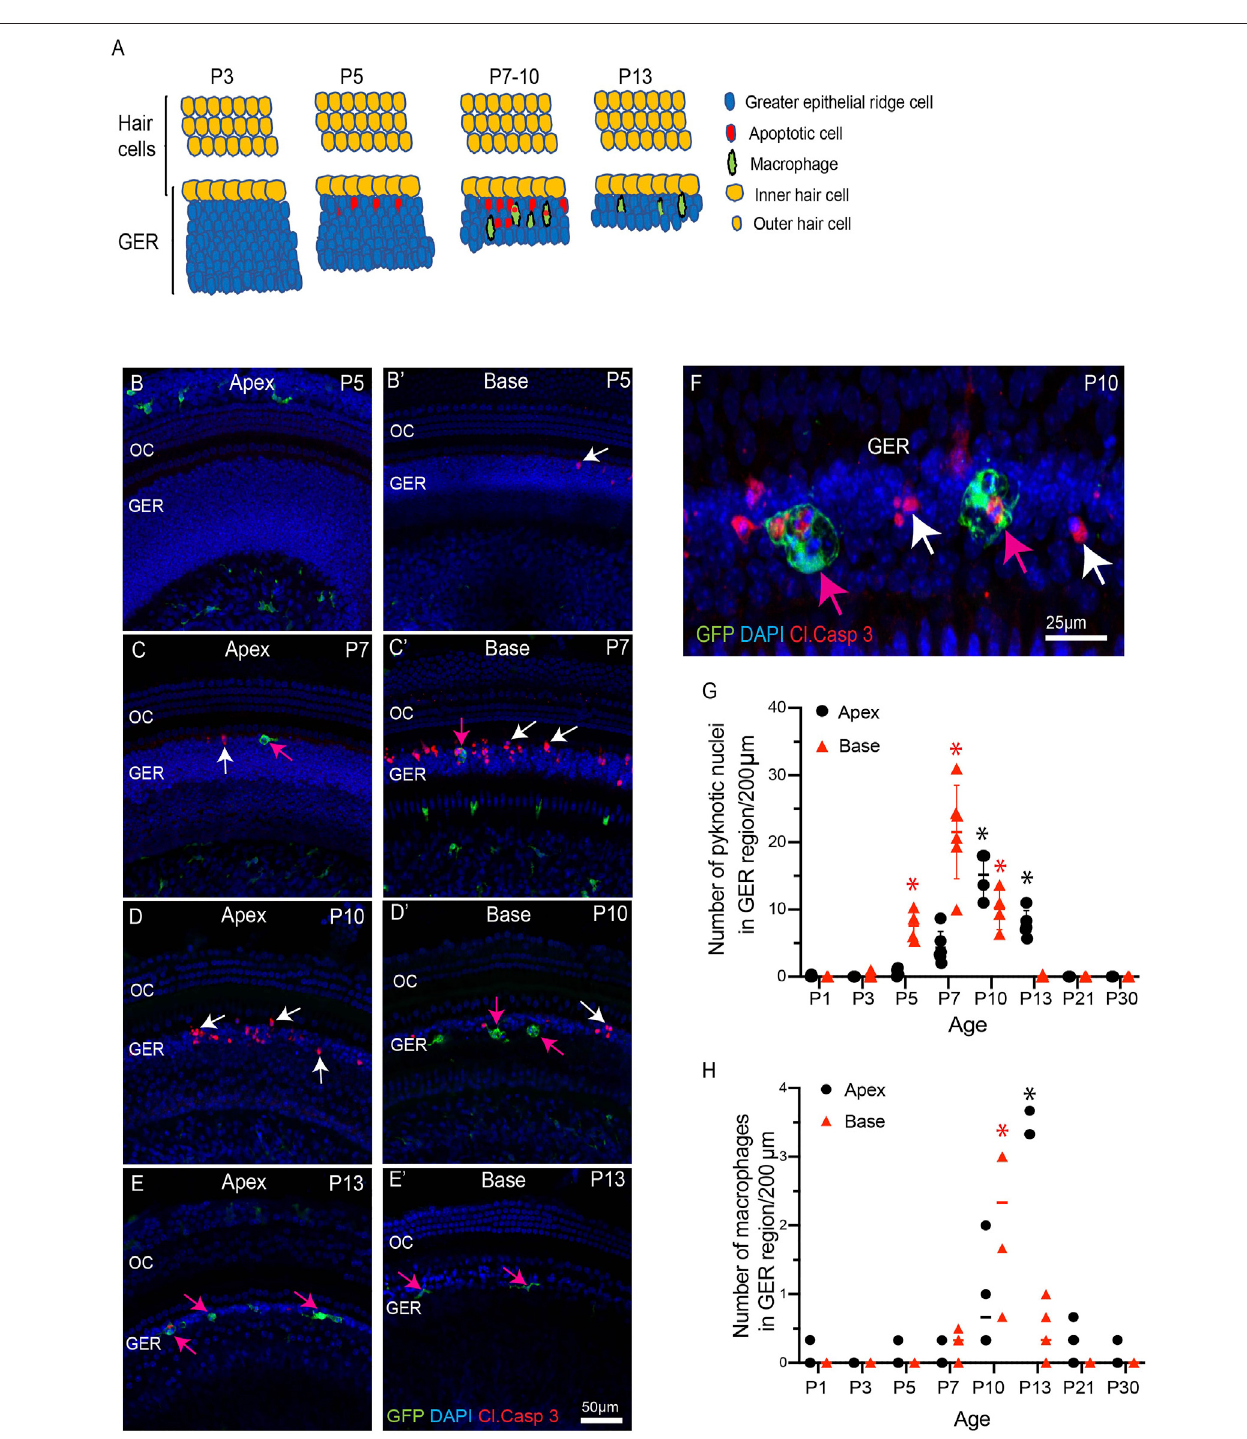
FIGURE 1 | Progression of apoptosis and macrophage recruitment in the developing cochlea of CX3CR1 GFP/+ mice. (A) Schematic representation of the patterns ofapoptosisandmacrophagerecruitmentintheGERregion. (B – E 9 ) Sensoryepitheliumofthedevelopingcochlea.Apoptoticcellswere fi rstobservedinthebasalregion at P5 [white arrow, (B 9 ) ] and the apex at P7 [white arrow, (C) ]. Cell death continued at later time points [white arrows, (C) , (D) , (C 9 ) , (D 9 ) ] and was accompanied by the recruitment of macrophages (magenta arrows). (F) A representative image of GFP-labeled macrophages engul fi ng pyknotic nuclei and activated caspase-3- labeled cells in the GER region at P10. (G) Number of pyknotic nuclei (a hallmark of apoptotic cells) in the GER region, as a function of developmental time. Cell death in the basal region peaked at P7, and in the apical region at P10. (H) Number of macrophages in the GER region, as a function of developmental time. The number of macrophagesinboththebasalandapicalregionspeakedat ∼ 3 daysafterthetimeofmaximalcelldeath.Imagesin (B-E 9 ) weretakenusinga × 20objectivelensandthe image in (F) was taken using a × 63 objective lens. Labels: Red-cleaved caspase 3, Green-GFP + macrophages, Blue-DAPI. White arrows: cleaved caspase-3-labeled (apoptotic ) cells, magenta arrows: GFP + macrophages. Abbreviations: OC: organ of Corti, GER: Greater Epithelial Ridge, *p: p < 0.05, relative to P1. (N (cid:2) 3 – 6).